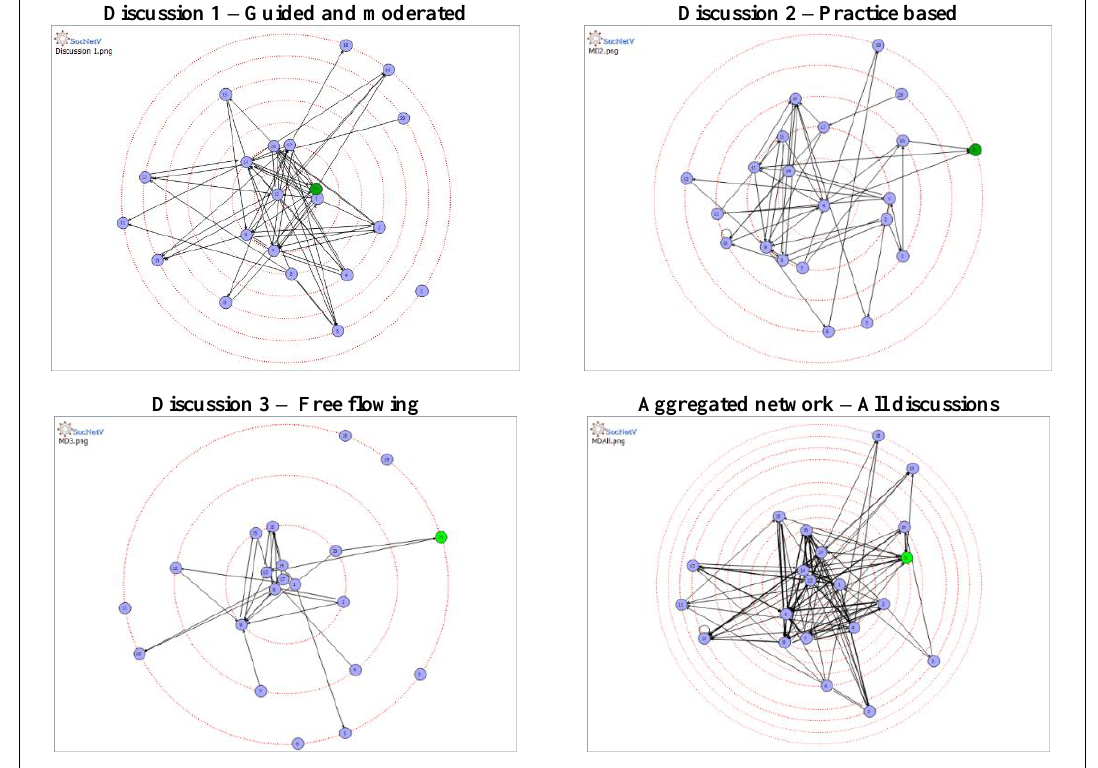
Figure 2. Discussion networks based on degree